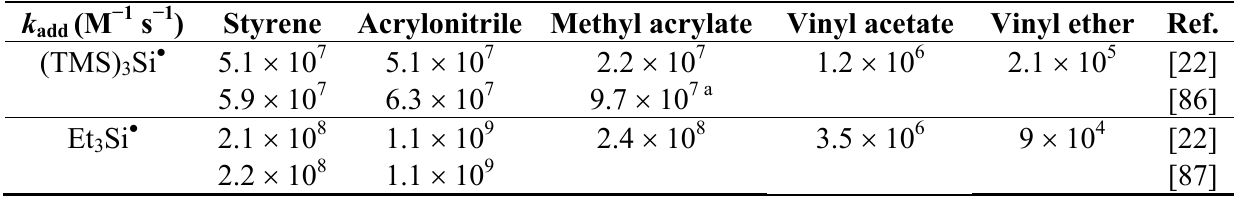
) for the addition of (TMS) add